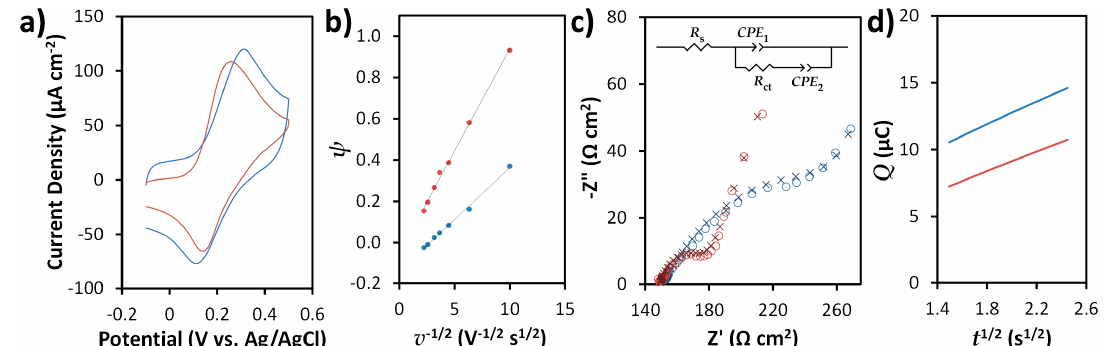
Figure 4. Electrochemical characterization of screen-printed carbon electrodes (SPCEs) (blue) and N-doped screen-printed carbon electrodes (N-SPCEs) (red). ( a ) Representative CVs for 0.5 mM FcMeOH with 0.1 M KCl obtained at a scan rate of 50 mV s − 1 . ( b ) Plots for determining heterogeneous electron transfer rate constant k 0 for the FcMeOH/FcMeOH + redox reaction based on the relationship between ∆ E P (expressed in terms of dimensionless kinetic parameter ψ ) and scan rate v . ( c ) Nyquist plots ( ◦ ) and models of data (x) based on an equivalent circuit (inset) for EIS measurements in 5 mM Fe(CN) 63 − / 4 − in 0.1 M KCl. ( d ) Anson plot used to determine electroactive surface areas from oxidation of 0.5 mM FcMeOH in 0.1 M KCl.